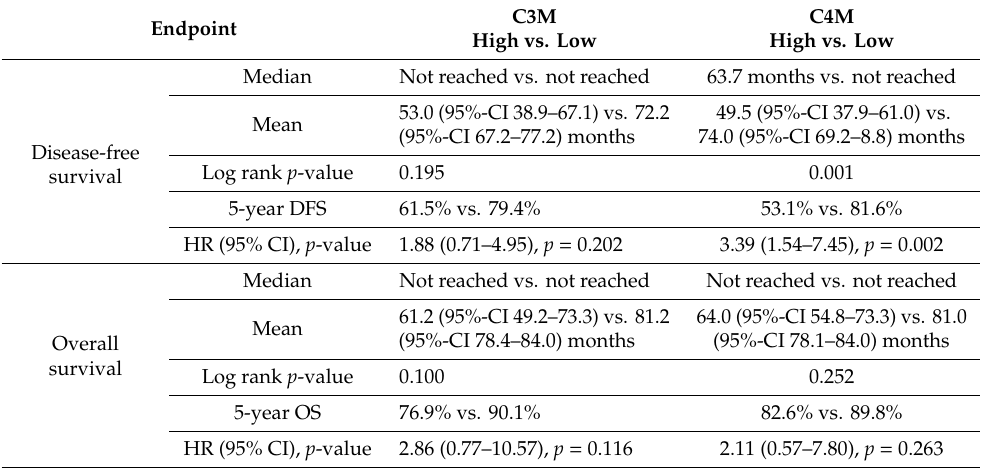
Table 4. Survival times in correlation with C3M and C4M levels at baseline.